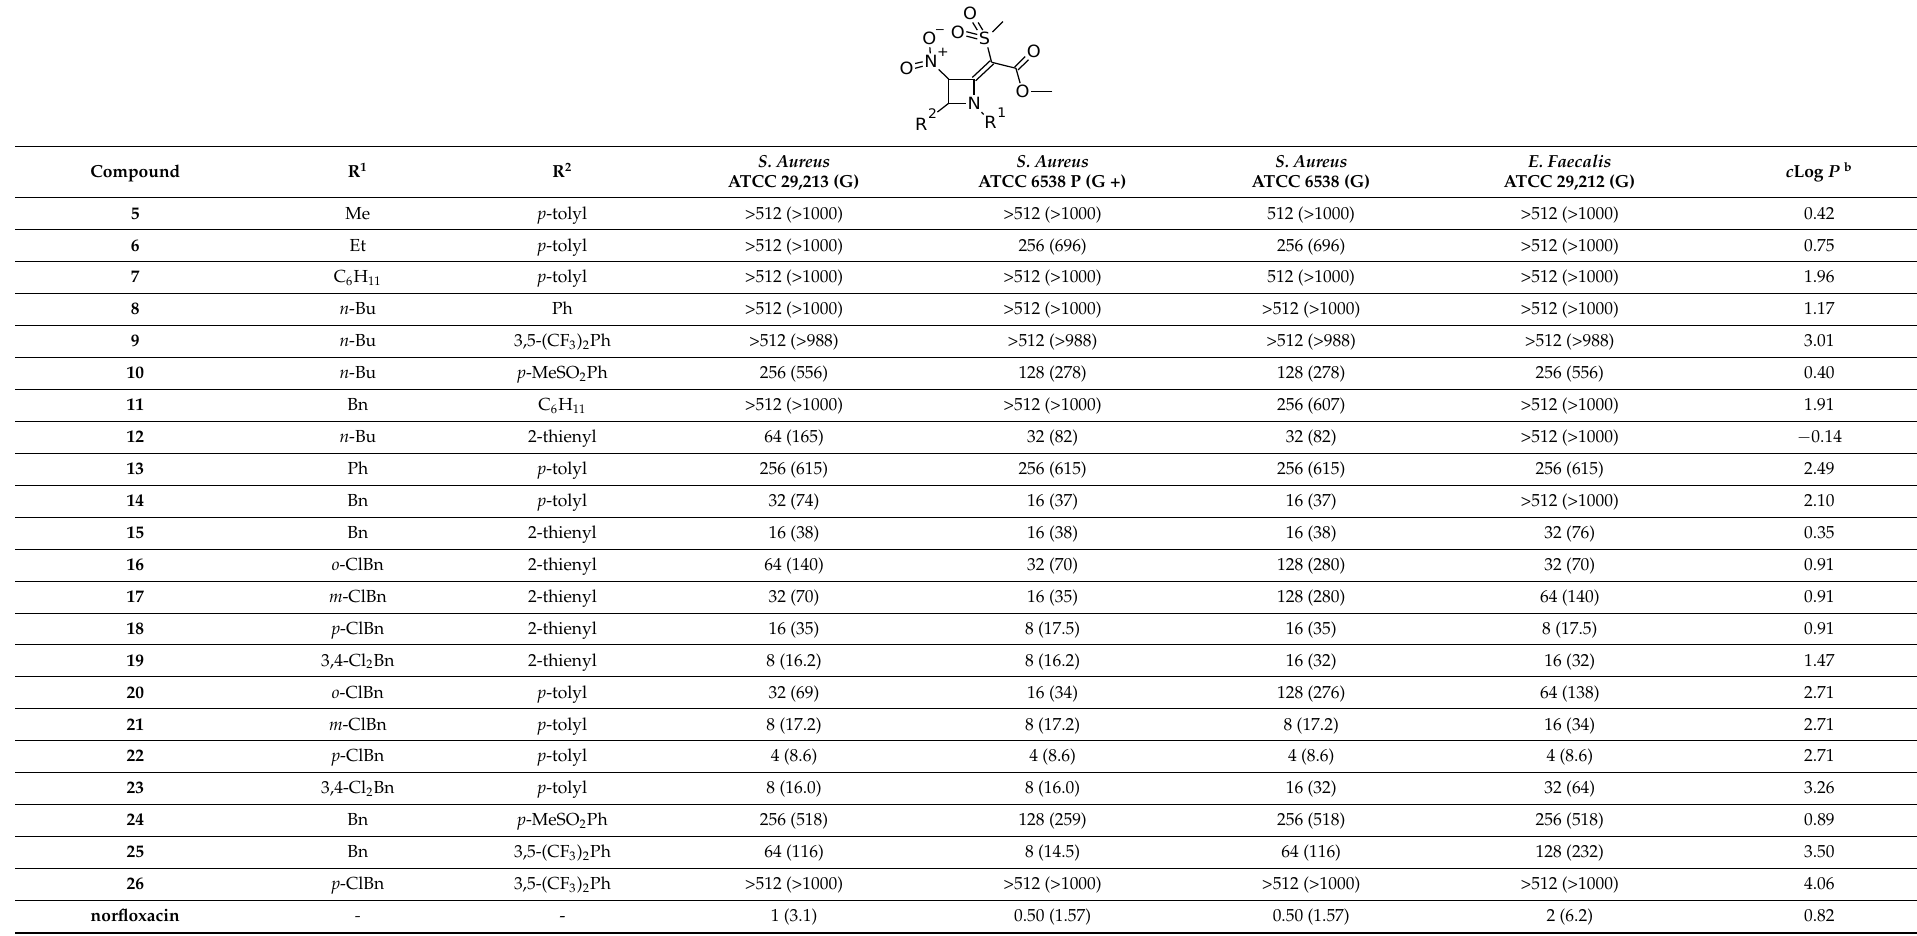
Table 1. Antibacterial activity of nitroazetidines 5–26 and norfloxacin (reference antibacterial agent) a .